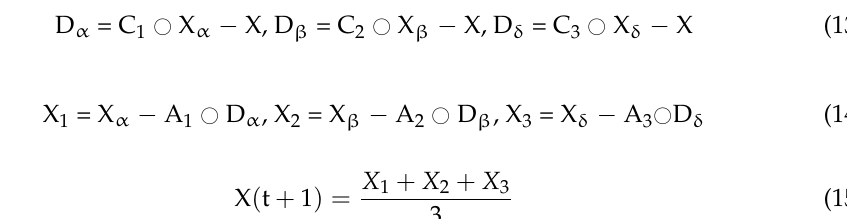
Figure 8. Schematic diagram showing the grey wolf hunting process. Grey wolves have the ability to identify the location of potential prey (optimal solu- tion), and the search process mainly depends on the α , β , and δ wolf finish. However, the spatial characteristics of the solution in many problems are unknown, and the grey wolf is unable to determine the exact location of prey (optimal solution). In order to simulate the search behavior of a grey wolf (candidate solution), suppose α , β , and δ have a strong ability to identify the location of potential prey. Therefore, the best three grey wolves ( α , β , and δ ) in the current race are retained during the whole recursive process, and then the location of other search agents is updated according to their location information. The mathematical model of this process is shown in Equation (13).